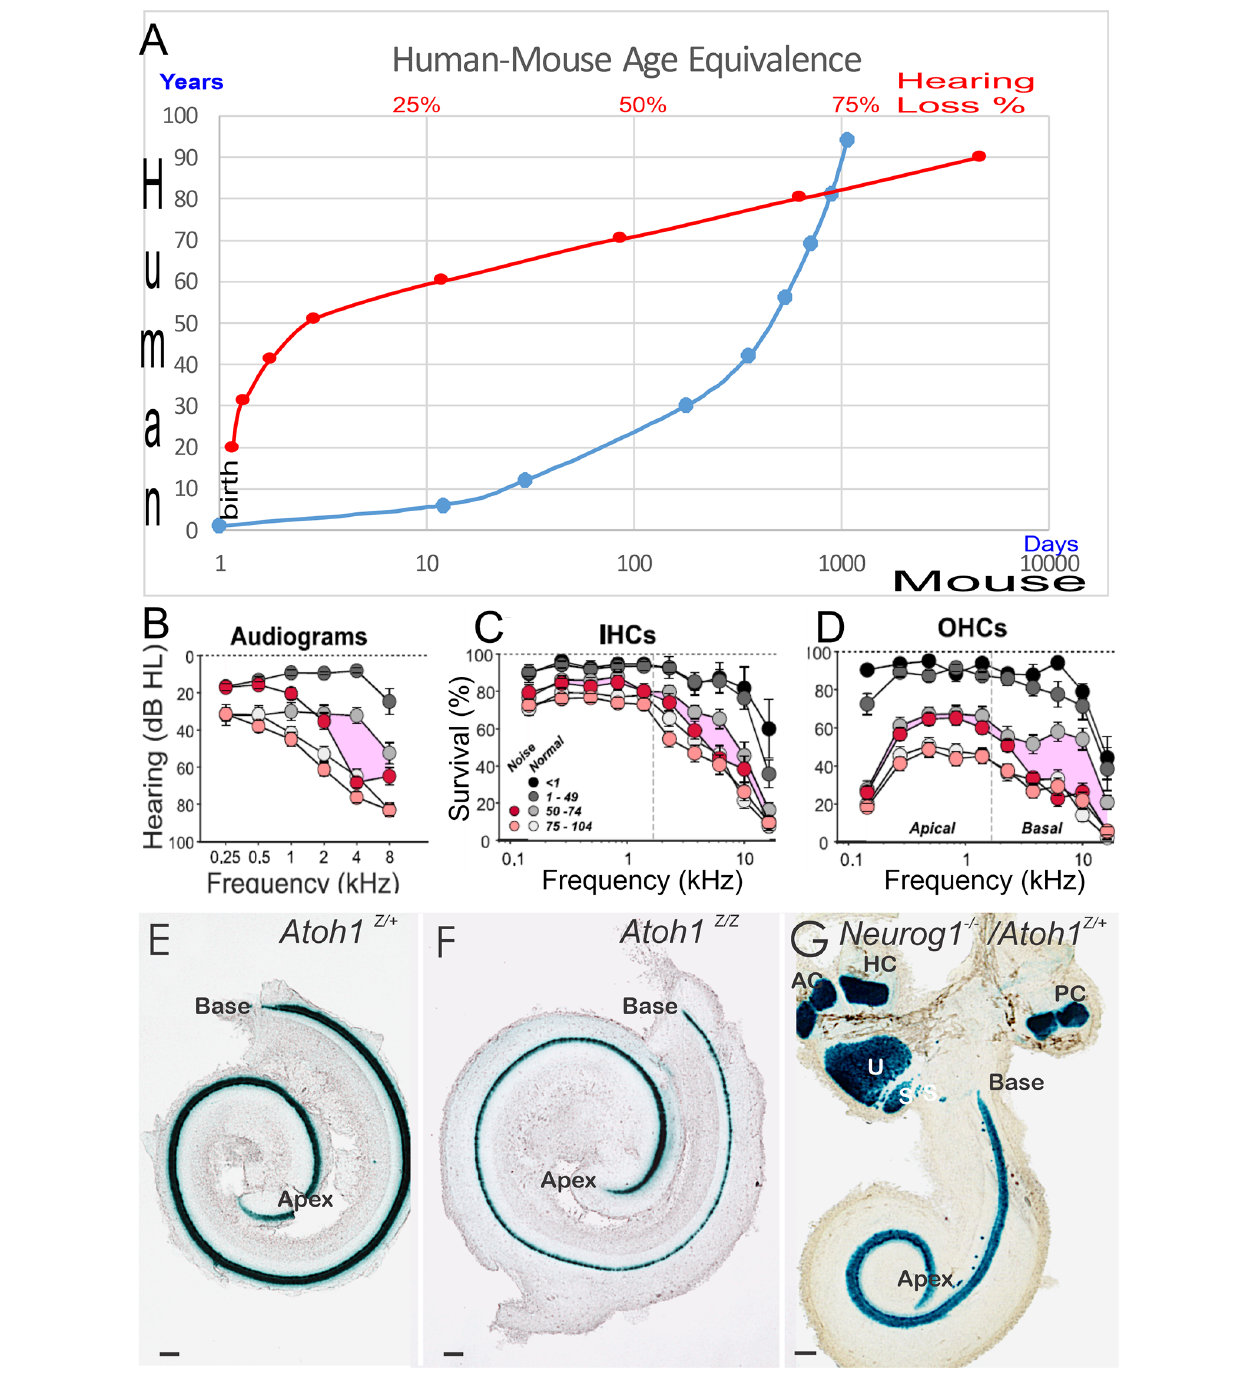
FIGURE 1 | Panel (A) provides an overview of a 70-year-old human comparable to a 2-year-old mouse. The age group in humans displays profound hearing decay, shown as percent (%) of hearing loss ( A , in red) follow-on hearing loss of 90-year-old humans. Limited restoration is attempted that has focused on 2-year or mostly younger mice, that is driven by the cost of keeping animals to old age and is providing a lack of decent models. Audiograms (B) and histology (C,D) demonstrated the loss of IHC (C) , OHC (D) , and the progressive threshold reduction in older people shown with the audiogram (B) . Note that people exposed to noise have an additional loss in hair cells (C,D) and show a threshold reduction in the audiogram (B) in the middle age of 50–74 years old. In newborn mice, we demonstrate the phenotype of Atoh1 LacZ in control mice (E) Atoh1LacZ/LacZ null mice (F) is comparable (i.e., a single row of undifferentiated IHCs). Compared to Neurog1 null mice, a shorter cochlea has outliers in the GER area (G) . Data were taken from the Jackson lab, WHF, and Fritzsch et al. (2005), Matei et al. (2005), Sheffield and Smith (2019), and Wu et al. (2021). Scale bars: 100 µ m (E–G) .